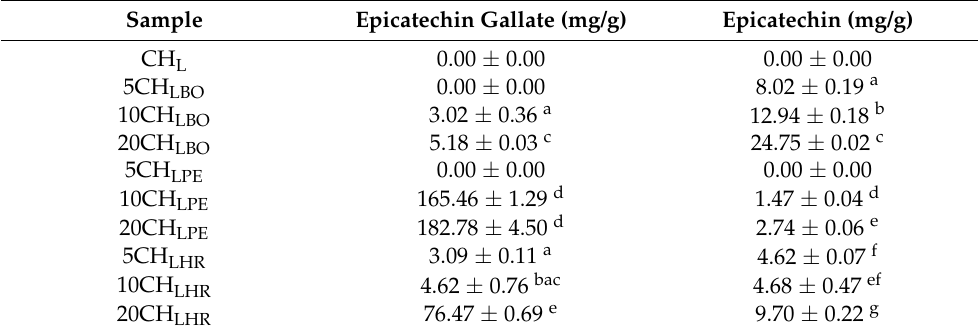
Letters in superscript indicate statistically significant ( p < 0.05) differences between rows. Table 9. Determination of epicatechingallate and epicatechine in chitosan films with the addition of blueberry, parsley and red grapes